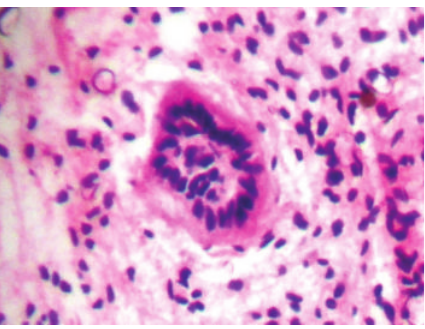
Figure 4: High power photomicrograph ( × 400) of odontogenic remnants showing blastemal cells with peripheral